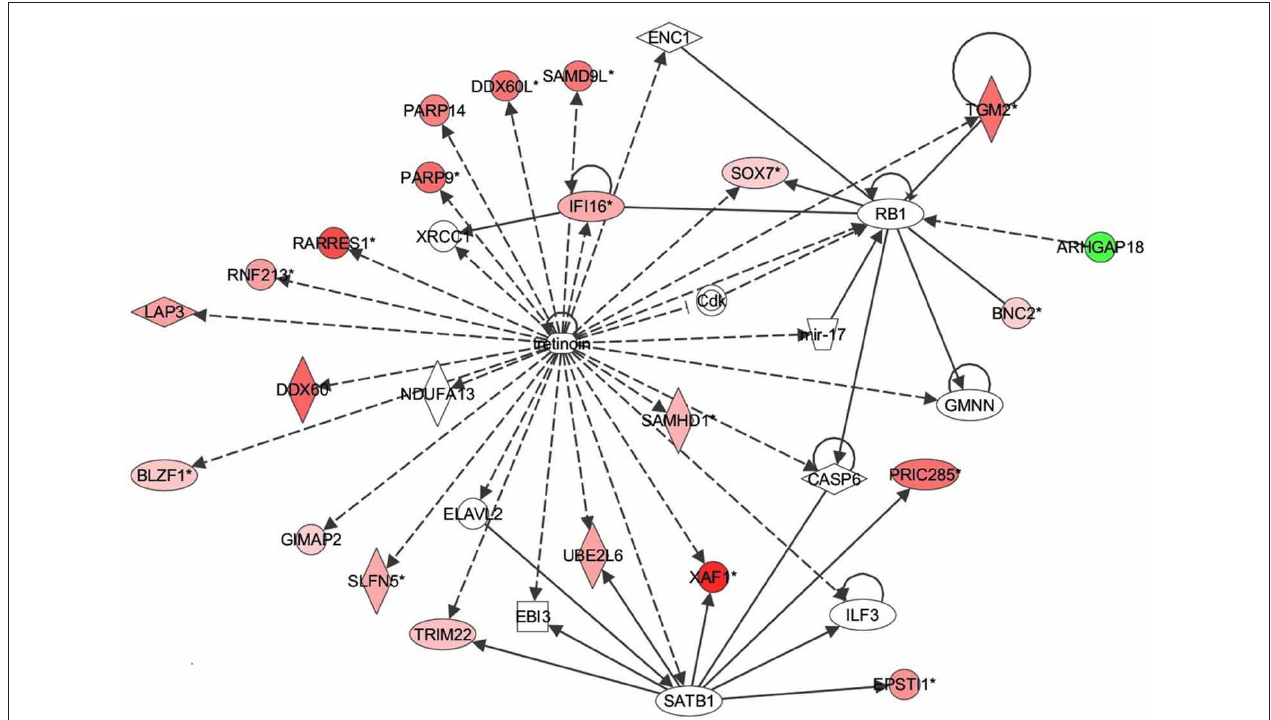
FIGURE 6 | Retinoic acid response signaling inflammatory mechanisms in bronchial epithelial cells exposed to Alternaria alternata spores. Genes that are significantly up-regulated are shown in red and genes that are down-regulated are shown in green. The intensity of red or green